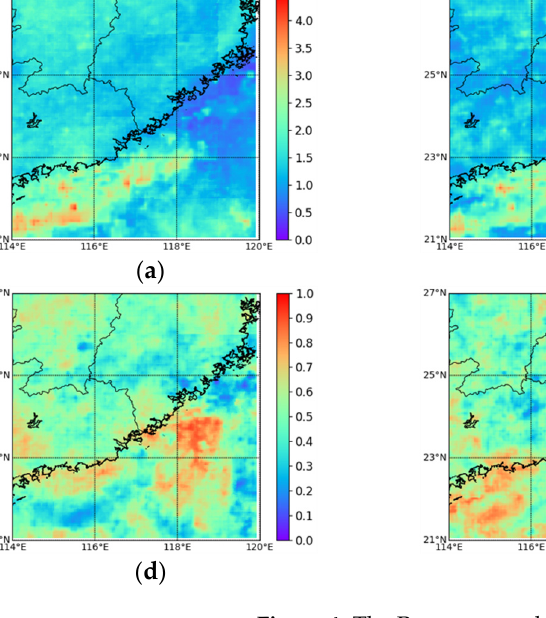
Figure 4. The Pearson correlation coefficient (CC) and Root Mean Square Error (RMSE) values for the CMORPH, FY4A-QPE and Attention-Unet model over the southeastern coast of China during the validation period (June–August 2020). ( a ) RMSE: FY4A-QPE; ( b ) RMSE: CMORPH; ( c ) RMSE: Attention-Unet; ( d ) CC: FY4A-QPE; ( e ) CC: CMORPH; ( f ) CC: Attention-Unet.